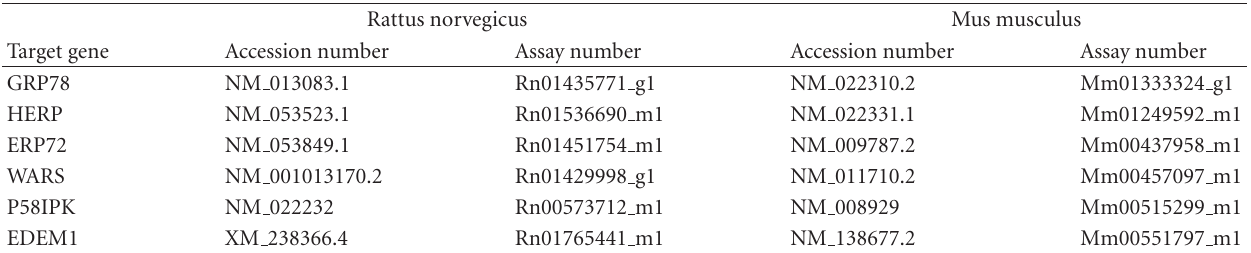
Table 1: List of TaqMan assays that reproducibly detect markers of